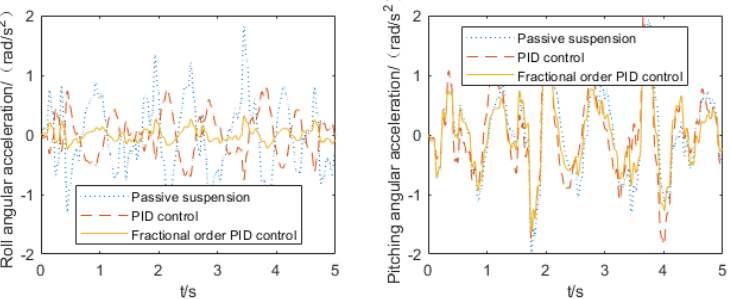
Figure 17. Pitching angular acceleration and roll angular acceleration simulation results.